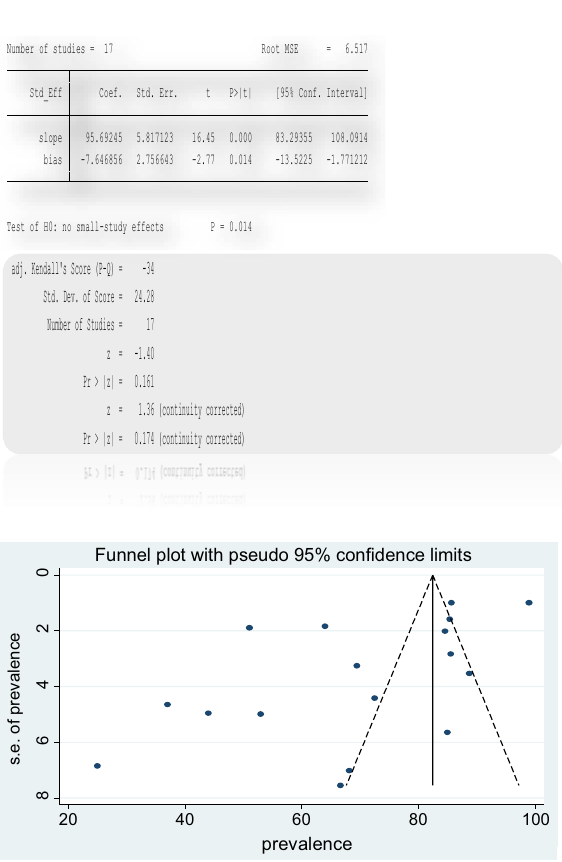
17Std. -1.40Number of Studies = 0.161z = Pr > |z| = corrected)z = 1.36 (continuity corrected) Pr > |z| = 0.174 (continuity